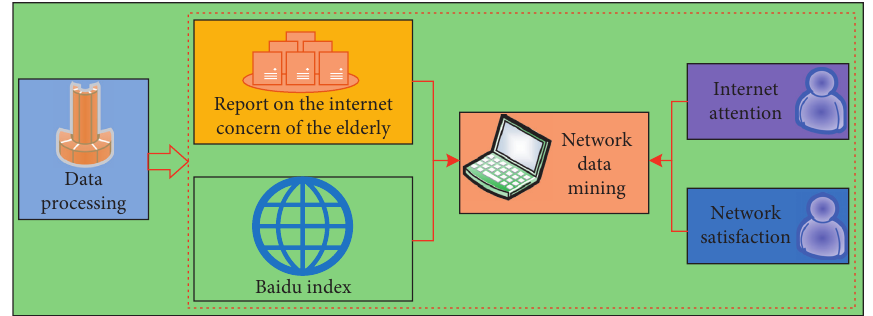
Figure 1: Mining the correlation between the elderly’s Internet attention and social service satisfaction.